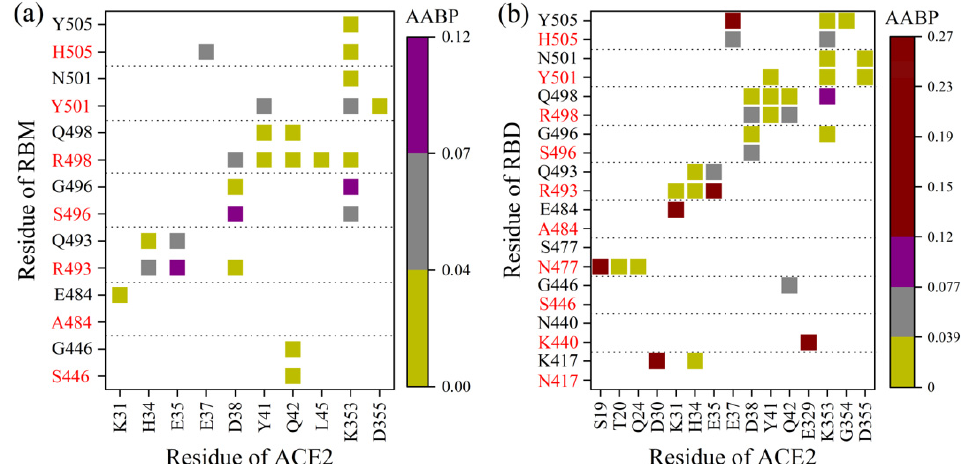
Figure 5. AABP pair map for ( a ) RBM–ACE2 (from reference [33]) and ( b ) RBD–ACE2 (from refer- ence [31]) for only the mutated OV residues (red characters on y-axis) that form pairs with ACE2, compared with their WT counterparts (black). Each square cell represents one pair for the intersection AA from RBM/RBD on the vertical axis and AA from ACE2 on the horizontal axis. These pairs have different strengths based on the AABP value.